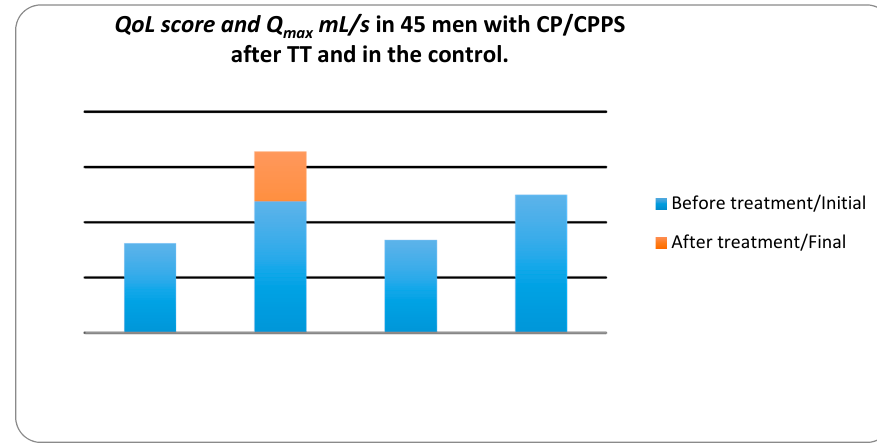
Figure 3. Quality of life (QoL) score and maximum urinary flow rate (Q max ) mL/s in 45 men with CP/CPPS after TT and in the control group measured by the National Institute of Health-Chronic Prostatitis Symptom Index (NIH-CPSI) and uroflowmetry.